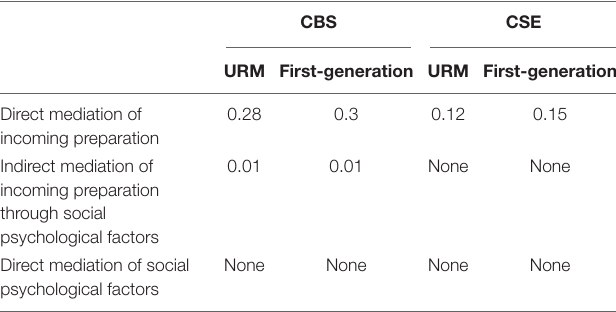
TABLE 6 | The size of different mediation paths for URM and first-generation (Fgen) students in exam performance across the College of Biological Sciences (CBS) and the College of Science & Engineering (CSE) in standard deviation units. CBS